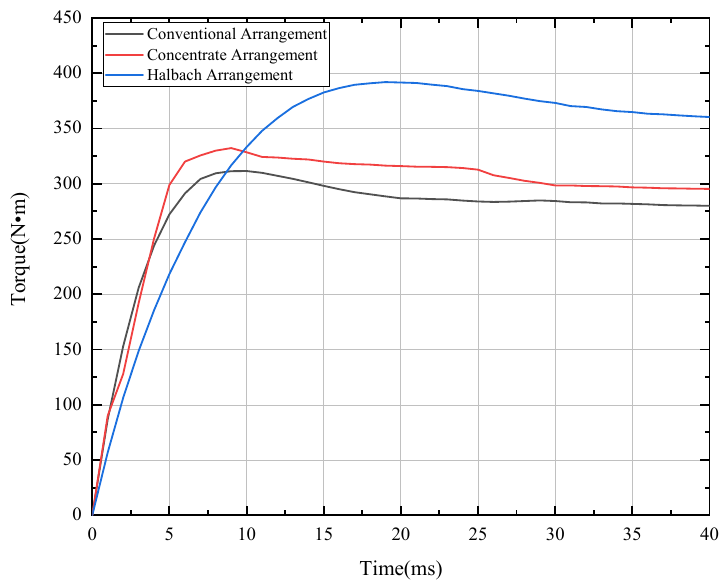
Figure 10. Output torque of CPMG under different magnets arrangements. Table 1. Comparison of the performance between different magnet arrangements.